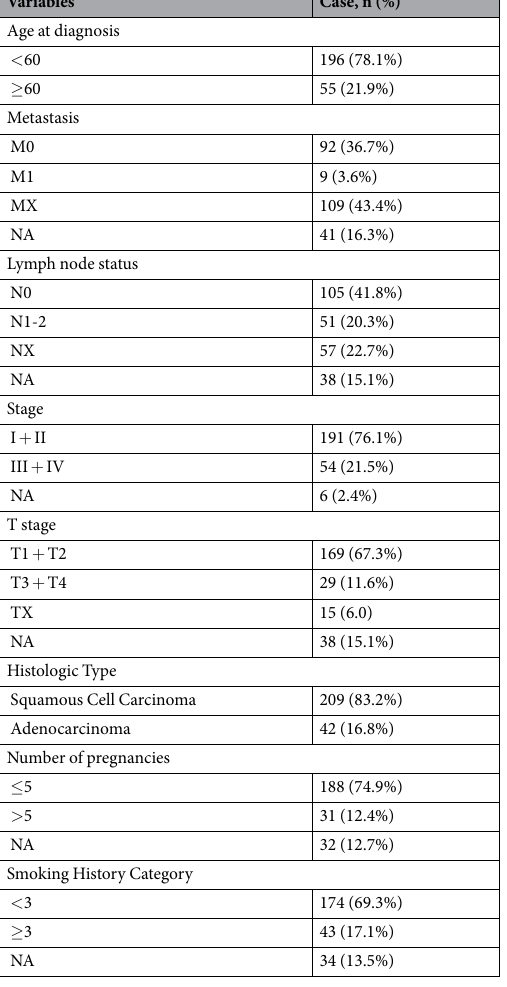
Table 1. Clinical characteristics of cervical cancer patients. NA, non